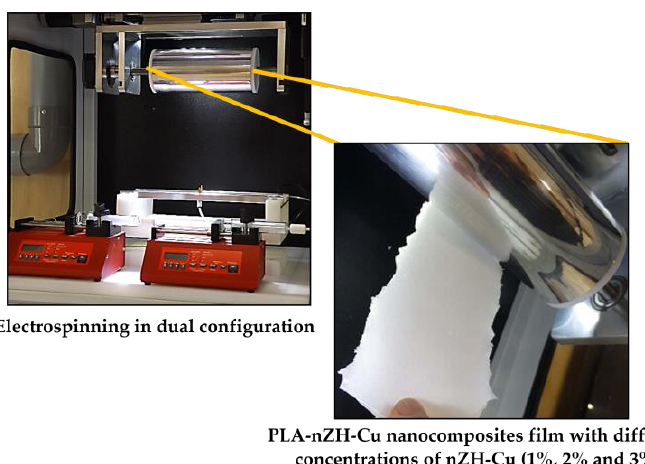
Figure 2. Nanocomposite films developed by the electrospinning technique in dual configuration with different concentrations of nZH-Cu (1%, 2%, and 3%). These nanocomposite films were used to wrap chicken breast meat.